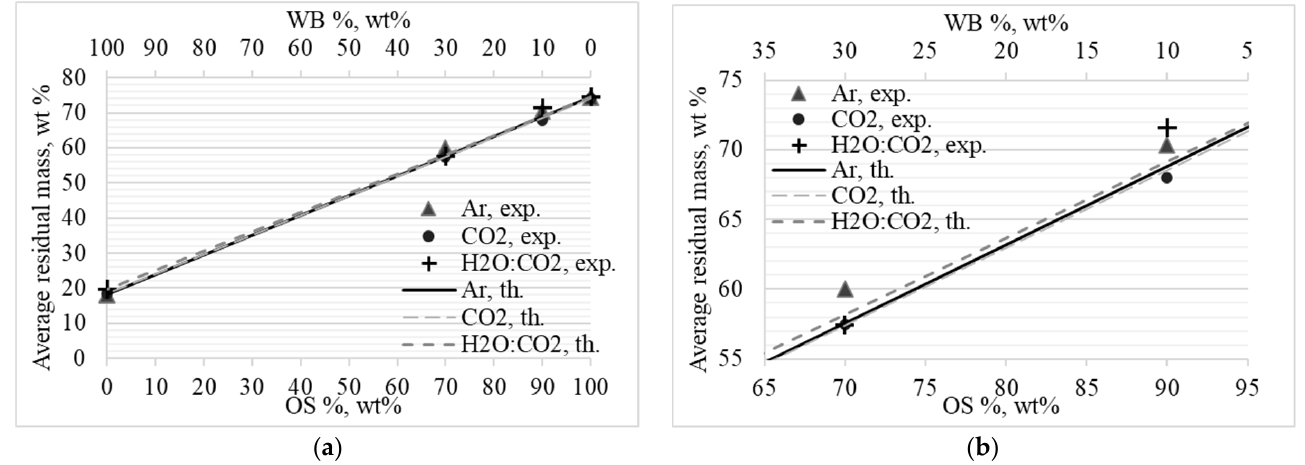
Figure 3. ( a ) Theoretical (th.) co-pyrolysis curves and experimental results (exp.). ( b ) Detail of theoretical (th.) and experimental (exp.) residual mass for co-pyrolysis blends.